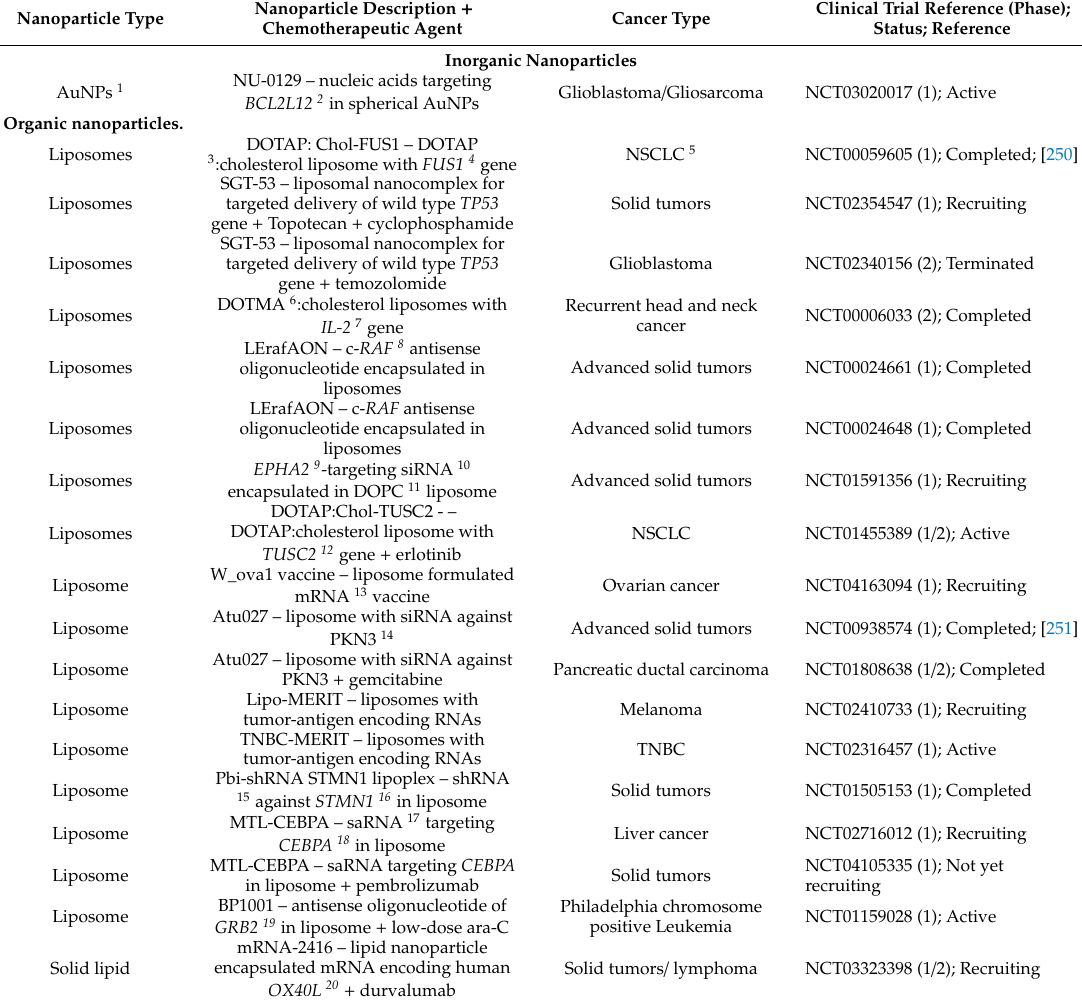
Table 6. Nanoparticles for gene therapy in interventional clinical trials. Data acquired from the U.S. National Library of Medicine